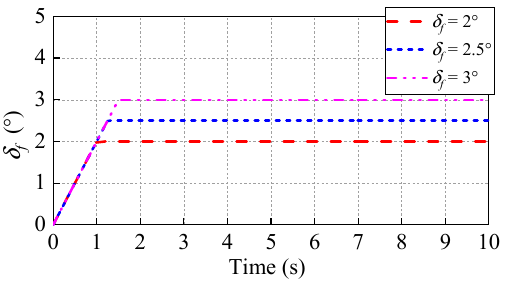
Figure 7. Ramp input of steering angle.